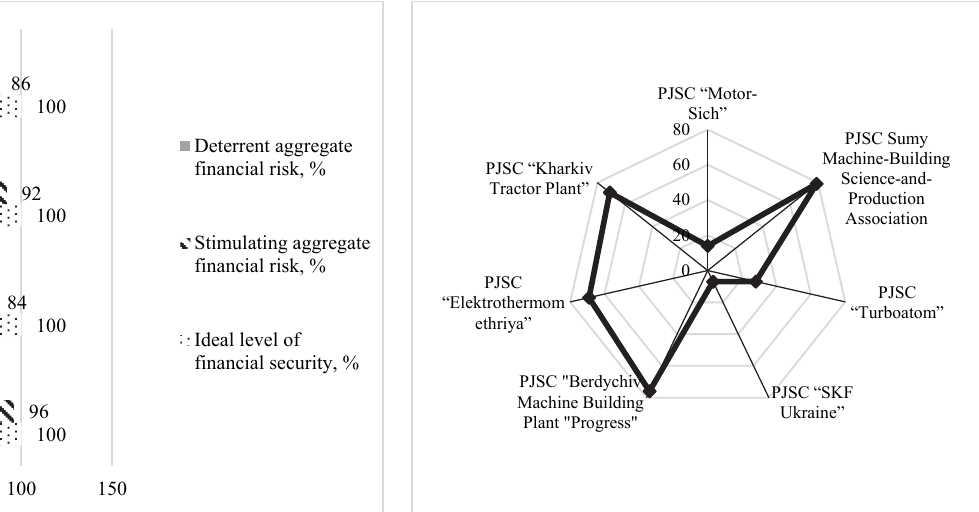
Fig. 3. Impact of restraining financial risk on the level of financial security of PJSC "Motor Sich" in 2015-2018, %*